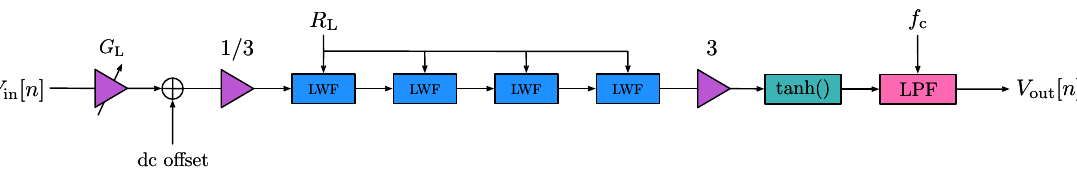
Figure 19. Block diagram for the proposed VA cascaded Lockhart wavefolder topology. Blocks labeled “LWF” and “LPF” indicate the Lockart wavefolder model and lowpass filtering, respectively.